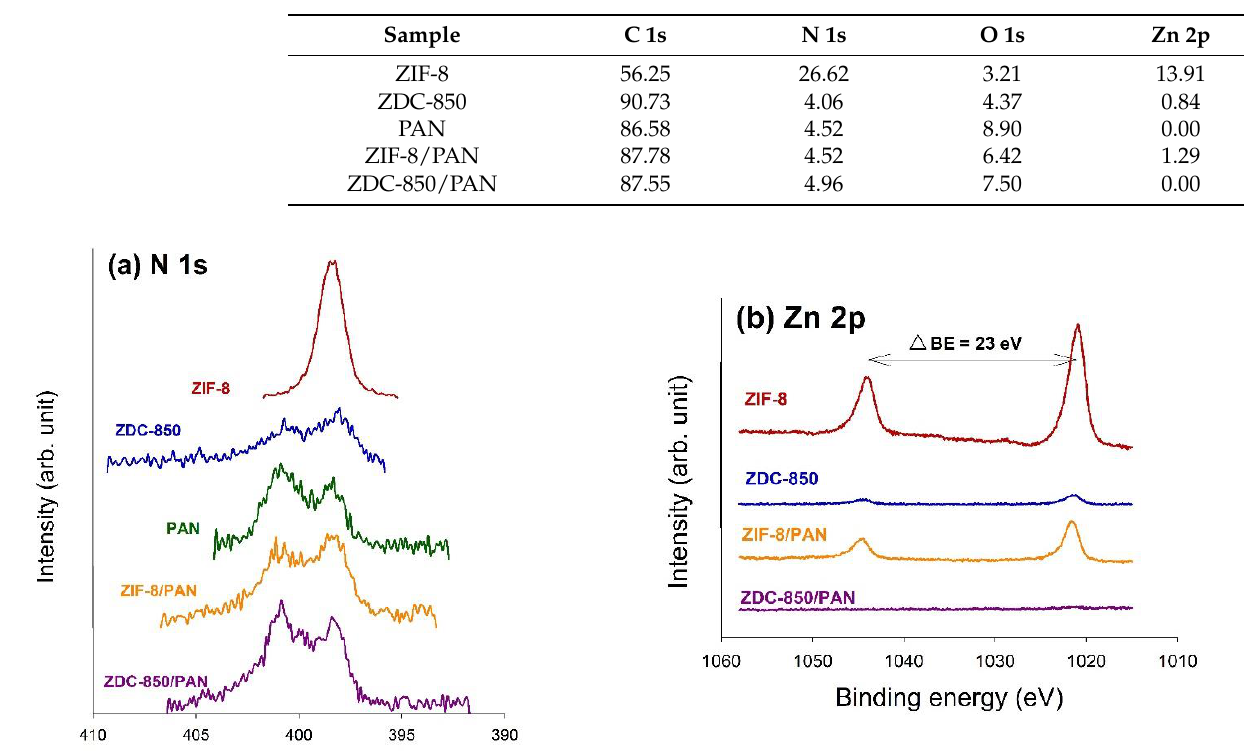
Figure 6. The X-ray photoelectron spectroscopy (XPS) profiles of the samples: ( a ) N 1s peaks; ( b ) Zn 2p peaks. Table 1. The atomic ratios (at.%) of surface elements from the X-ray photoelectron spectroscopy (XPS) profiles.